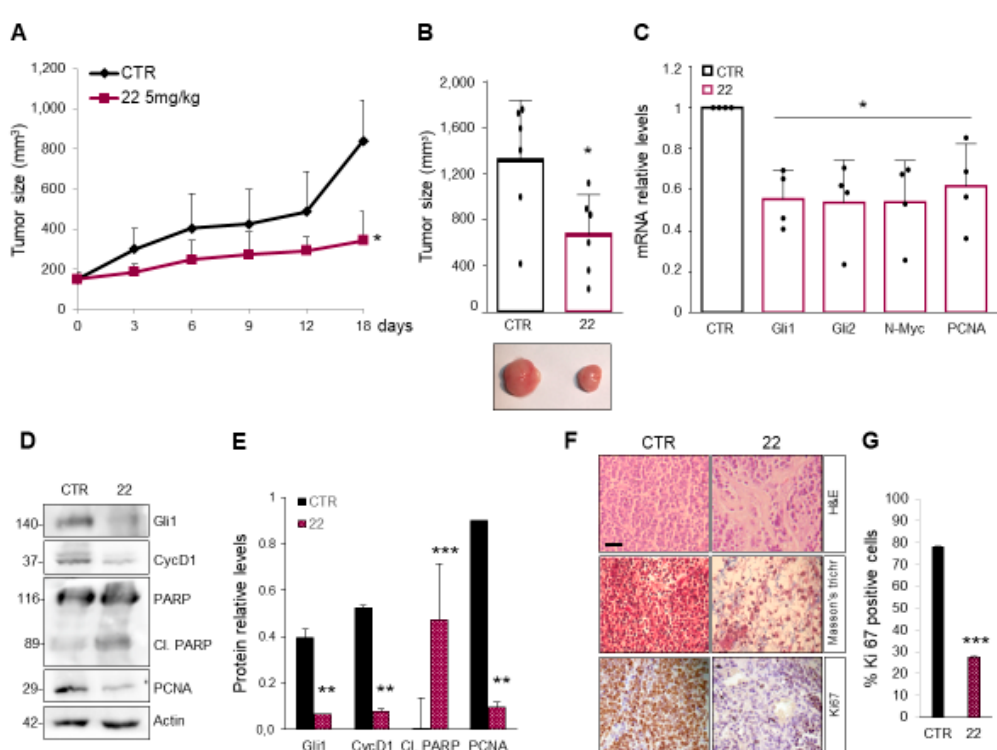
Figure 7. Compound 22 impairs Hh-dependent tumor growth in vivo. ( A ) BALB / c nude mice ( nu / nu ) were grafted with spontaneous primary MB from Math1-cre / Ptc C / C mice. Tumor masses (150 mm 3 ) were injected with compound 22 or solvent only. Tumor growth was monitored during the treatment period. ( B ) Representative flank allograft average volumes (lower panel) and quantification of tumor explants (upper panel). ( C ) The graphs show mRNA expression levels of Gli1 , Gli2 , N-Myc and PCNA determined by qRT–PCR and normalized to endogenous control β 2-microglobulin and Hprt . ( D , E ) Western blot and densitometric analysis show Hh target protein and proliferation marker expression levels from the tumor masses assayed in B . ( F ) Hematoxylin / Eosin (H&E), Masson’s trichrome and Ki67 staining of representative tumor masses. Scale bar 100 µ m. ( G ) Quantification of Ki67 immunohistochemical staining, shown in F . Data show the mean ± S.D. of tumor ( n = 6) for each treatment. (*) p < 0.05 vs. CTR; (**) p < 0.01 vs. CTR; (***) p < 0.001 vs.